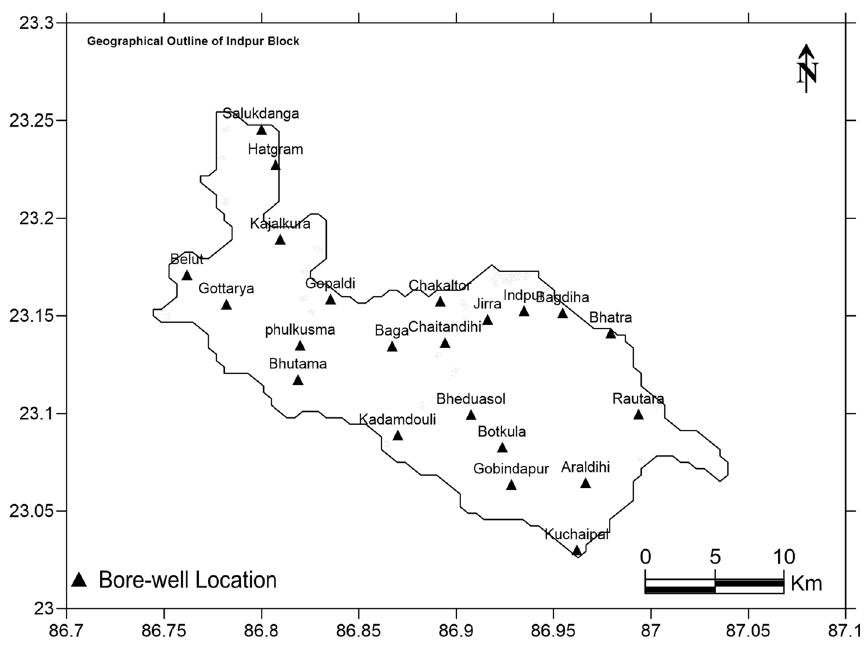
Fig. 2 Locations of the sam- pling wells within the